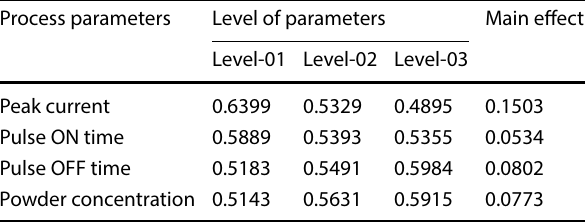
Table 7 Response table—grey relational